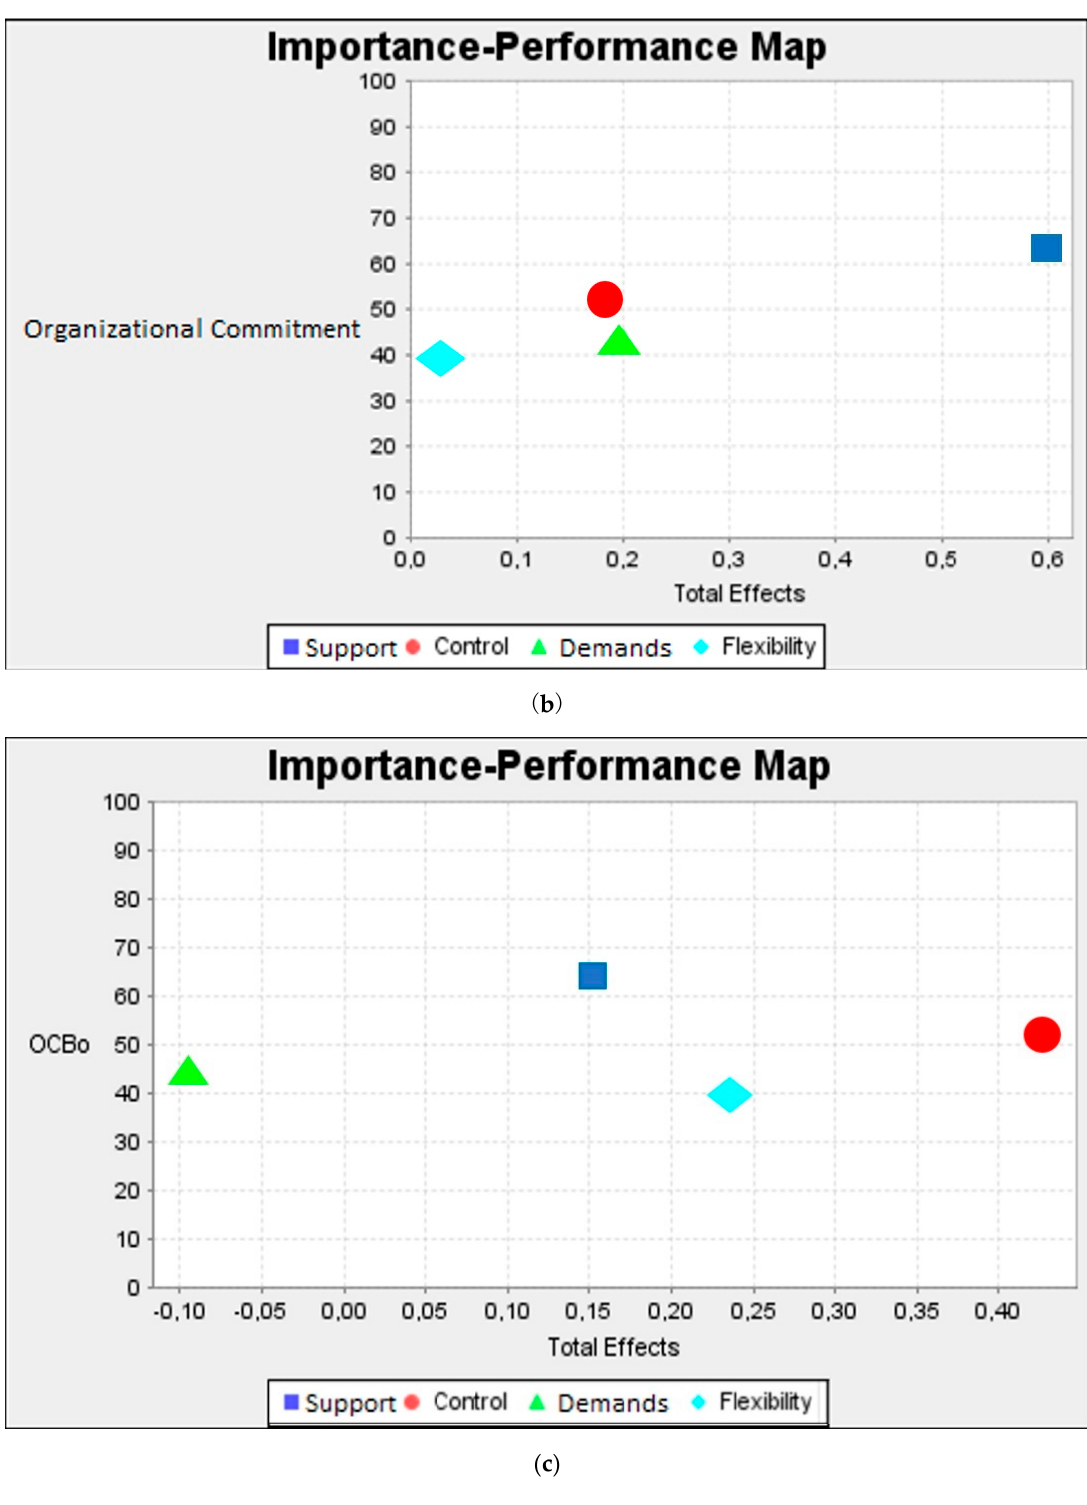
Figure 3. IPMA for support, control, demands, and flexibility-oriented culture on the three criterion variables. ( a ) IPMA on job satisfaction; ( b ) IPMA on organizational commitment; ( c ) IPMA on organizational citizenship behavior towards the organization.